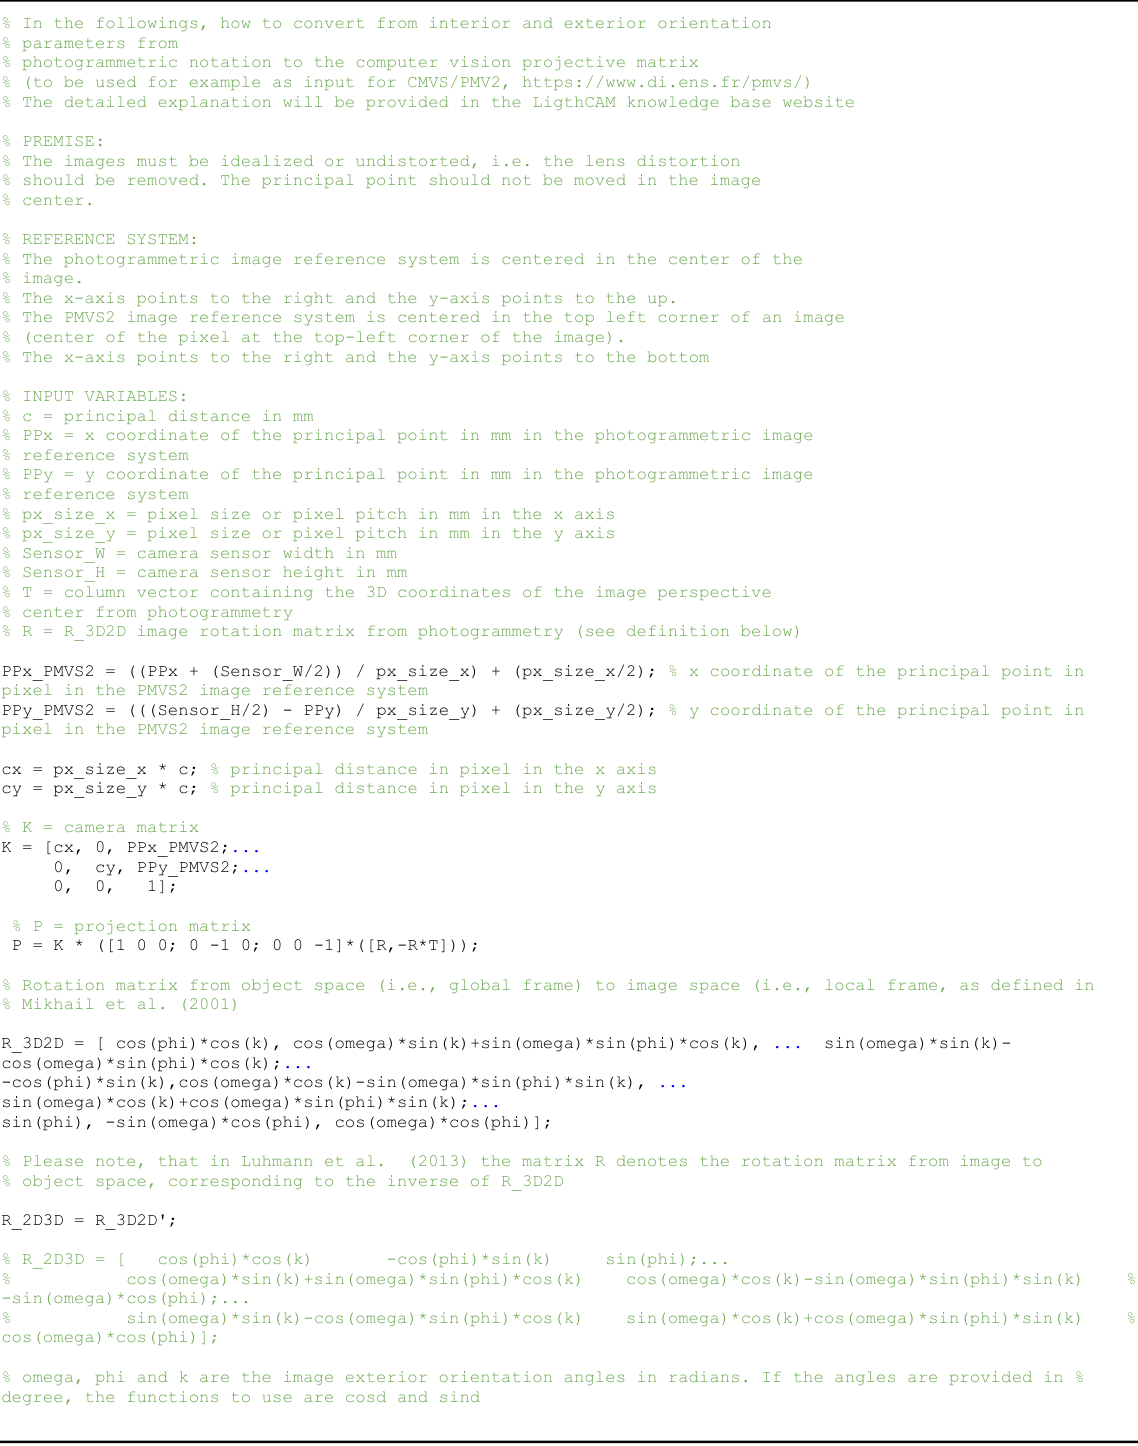
Figure 3: Example of exchange code, which will be included in the LightCam code